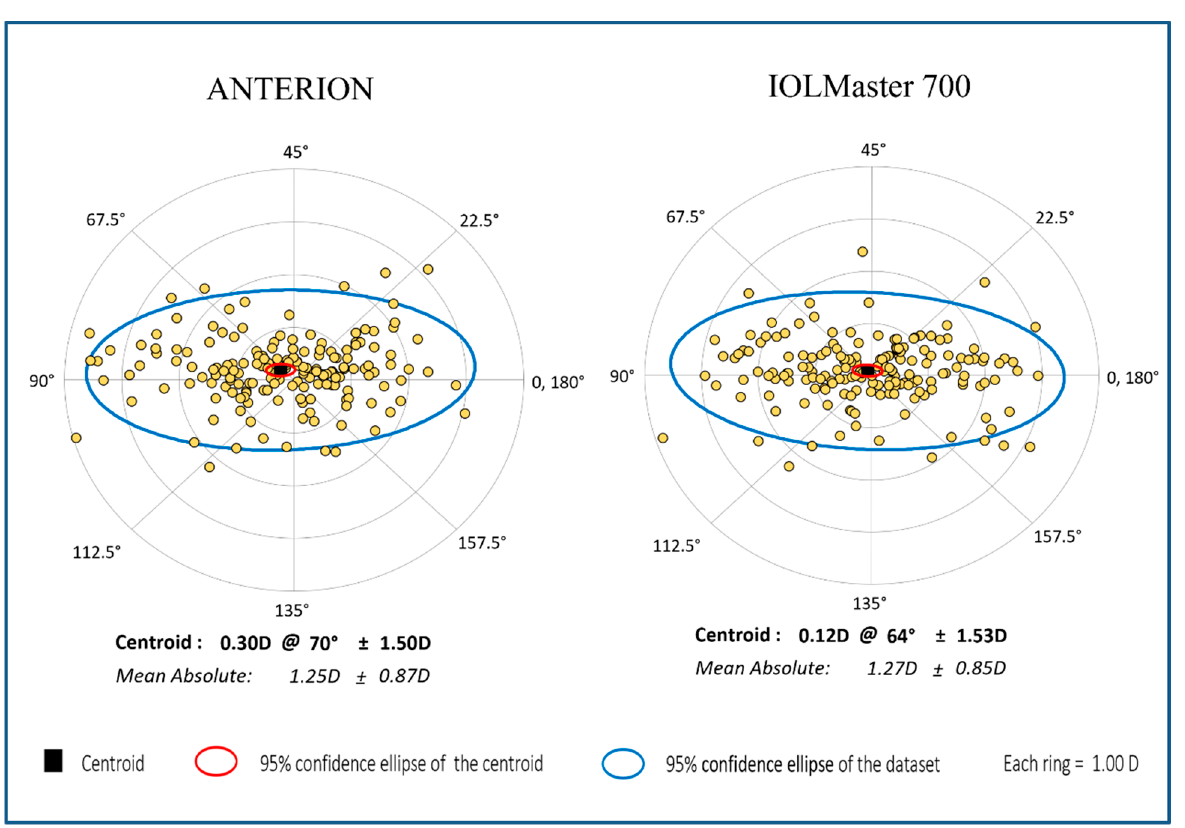
Figure 2. The double-angle plot of anterior corneal astigmatism of ANTERION and IOLMaster 700. Table 1. Anterior corneal astigmatism difference between the two devices.